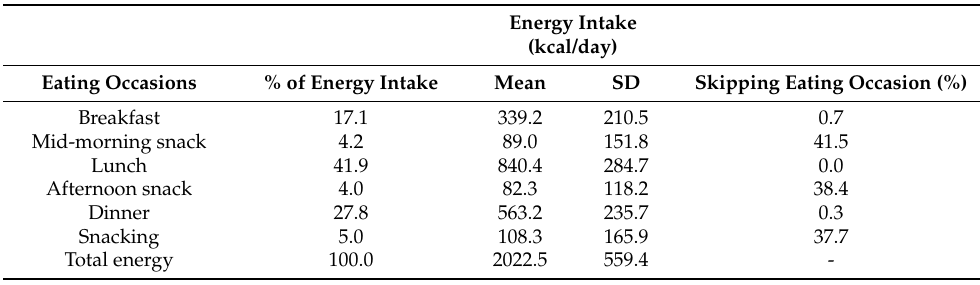
Table 1. Energy intake at each eating occasion, and percentage of individuals who skipped each eating occasion, among the study participants at baseline. Seniors-ENRICA-1 cohort study, 2008–2010. N = 607.